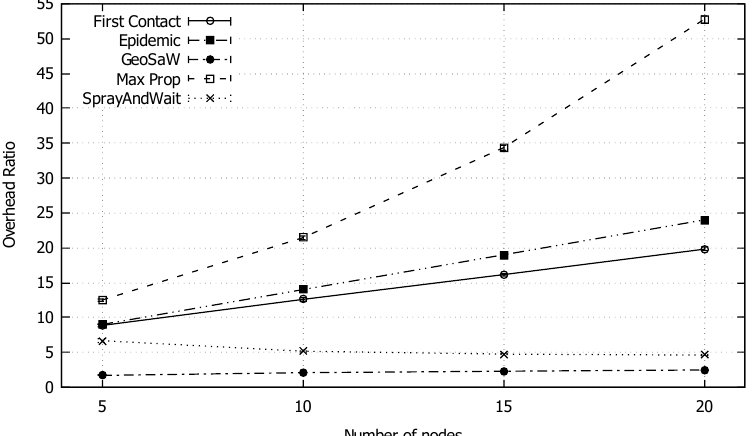
Figure 5. Average overhead ratio of GeoSaW compared with other DTN routing protocols when varying the number of nodes.